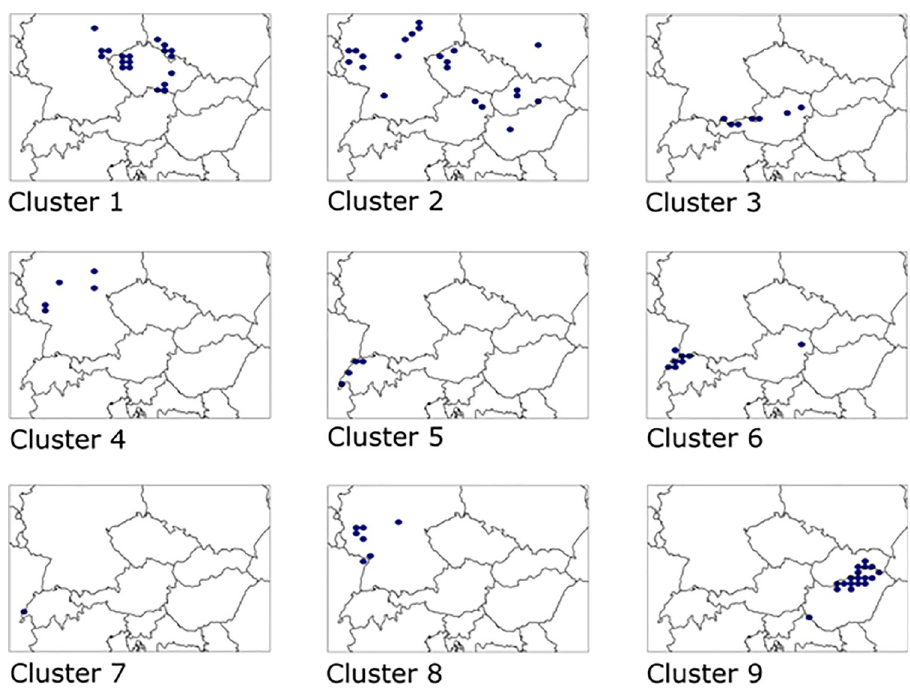
Fig 2. Distribution of the natural rocky scrub communities across Central Europe. Cluster 1 – Cytiso scoparii- Cotoneasteretum integerrimi ; Cluster 2 – Cotoneastro integerrimi-Amelanchieretum ovalis ; Cluster 3 – Erico carneae- Amelanchieretum ovalis ; Cluster 4 – Calluno vulgaris-Amelanchieretum ovalis ; Cluster 5 –comm. Cotoneaster tomentosus-Amelanchier ovalis sensu Moor 1979; Cluster 6 – Coronillo emeri-Prunetum mahaleb ; Cluster 7 – Cotoneastro integerrimi-Sorbetum chamaemespili ; Cluster 8 – Pruno spinosae-Ligustretum vulgaris subass. with Cotoneaster integerrimus ; Cluster 9 – Waldsteinio geoidis-Spiraeetum mediae . Maps were prepared using mapping software DMAP 7.5